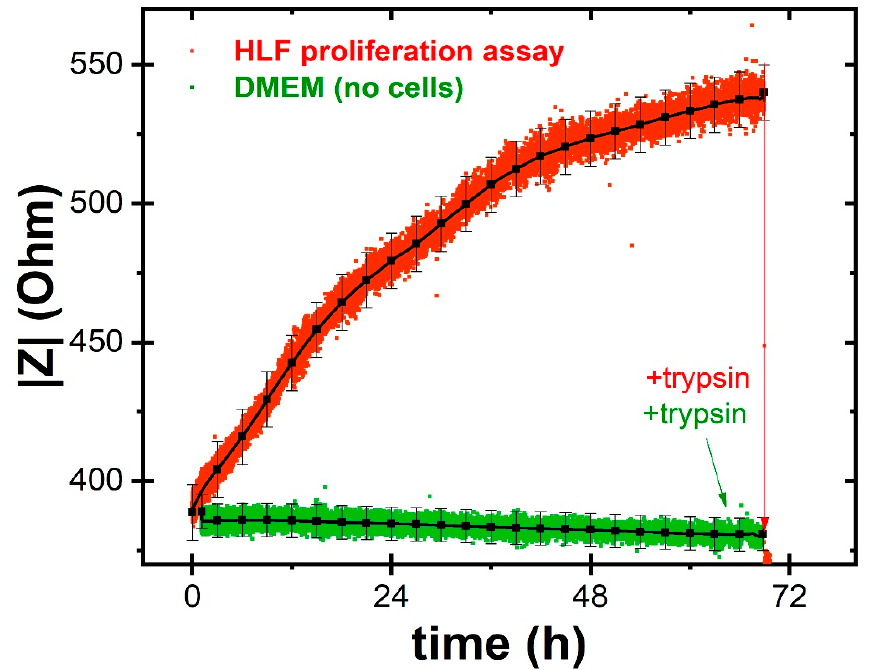
Figure 2. Results of on-chip HLF proliferation assays performed with the ECIS technique. The red curve corresponds to data acquired during HLF proliferation over a three days’ period: the impedance values increase toward a stationary phase and then return to about the initial values once trypsin is added to detach the cells. The green curve is associated to the control experiments with only culture medium and exhibits a practically constant trend. Black curves show mean ± standard deviation including other ECIS sensors in the statistical analyses.